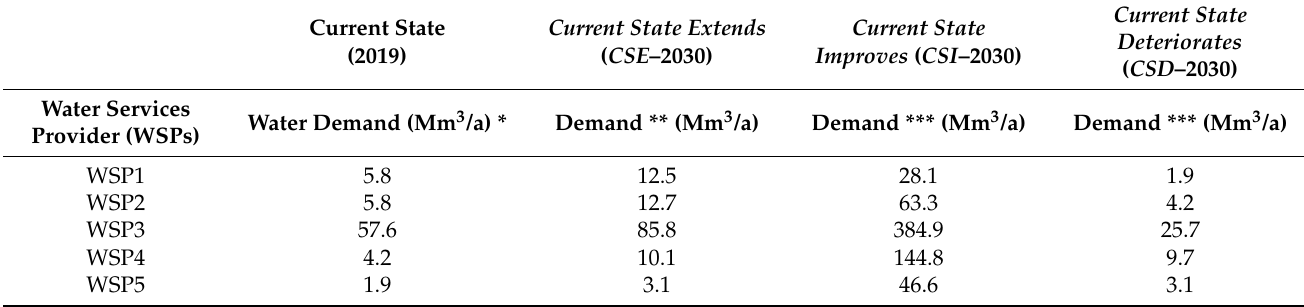
Table 8. Water demand for 2019 (current state) and 2030 under the three scenarios.